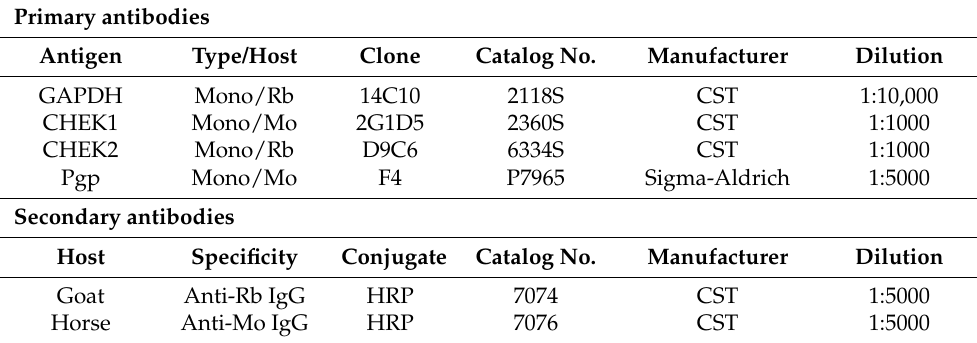
Table 5. Primary and secondary antibodies used for immunoblotting.